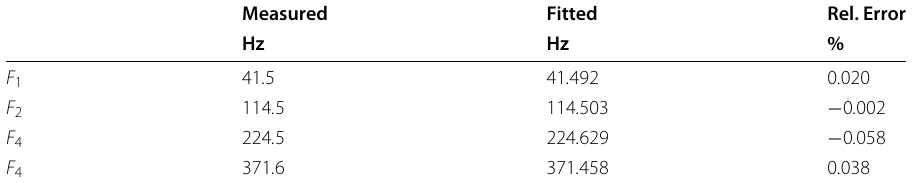
Table 6 Frequency-fitting for the beam with